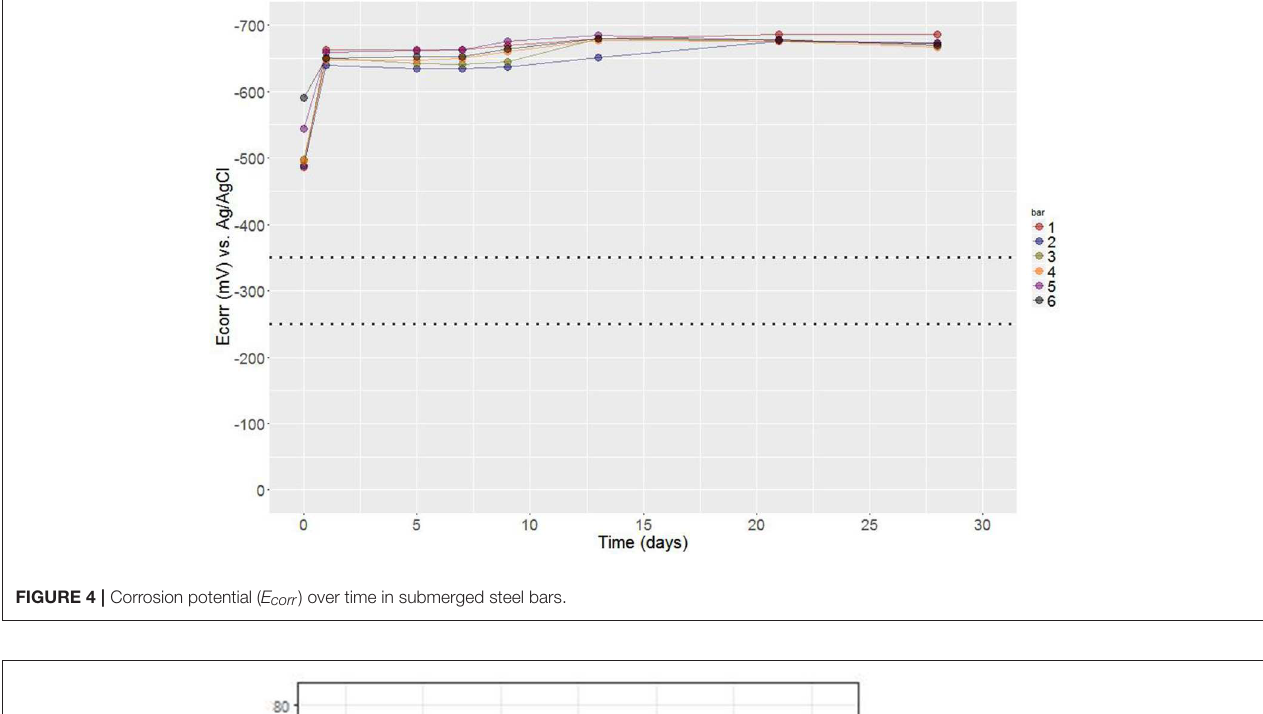
FIGURE 4 | Corrosion potential ( E corr ) over time in submerged steel bars.